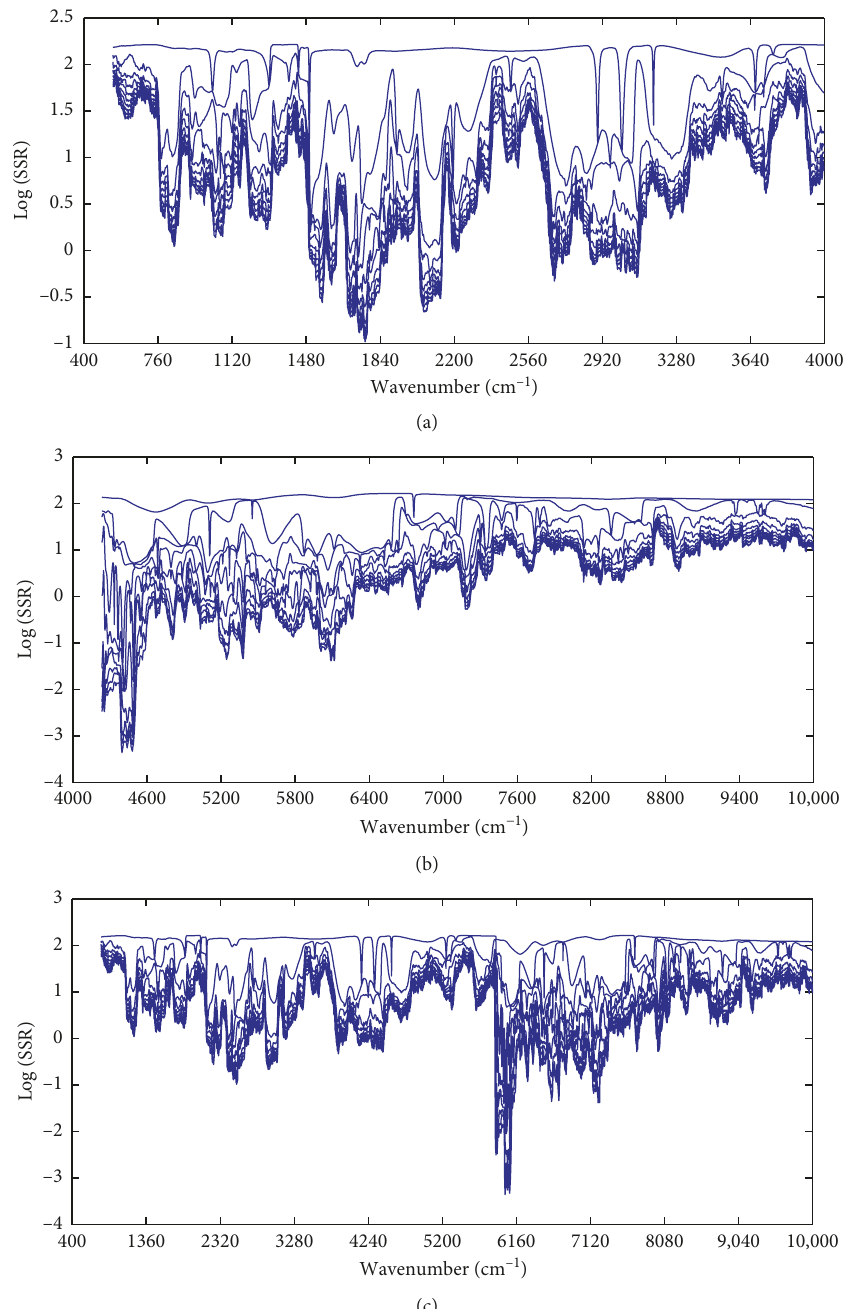
Figure 3: (a) Residue lines obtained by MWPLS for the training sets in MIR spectroscopy; (b) residue lines obtained by MWPLS for the training sets in NIR spectroscopy; (c) residue line obtained by MWPLS for the training sets in the fusion of MIR and NIR